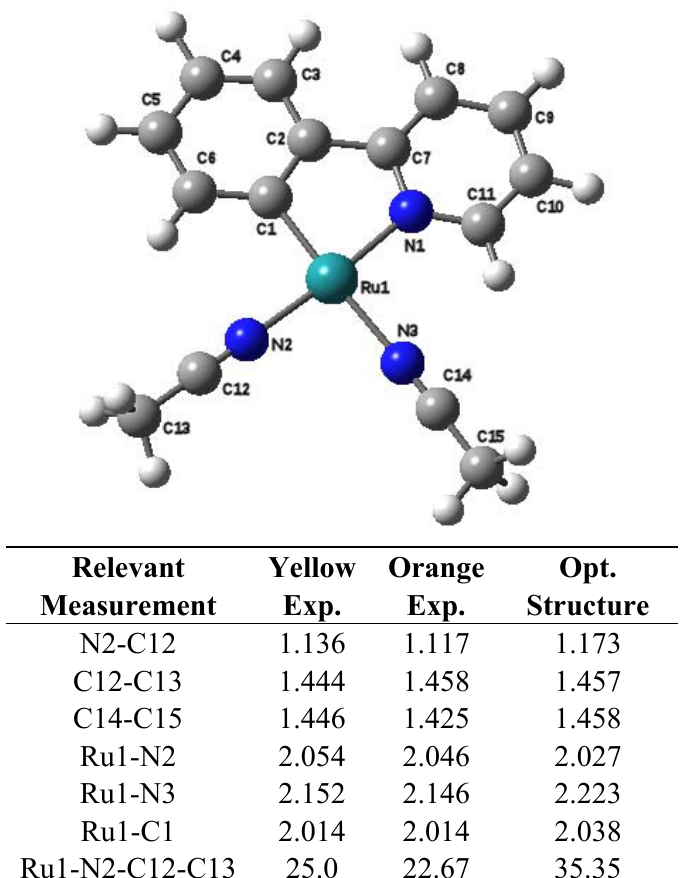
Figure 2. Fragment of the compound in the equatorial plane and relevant